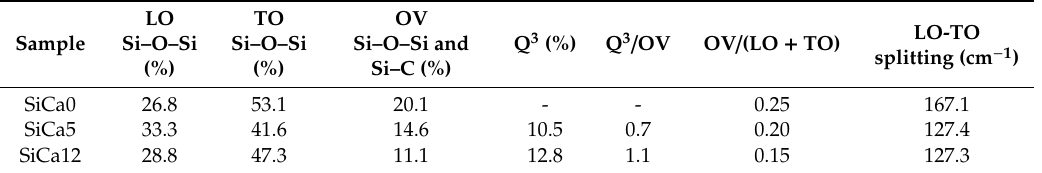
Table 2. Percentual fractions of band area and area ratios of fitted bands from the FTIR spectra shown in Figure 4 and the calculated LO-TO splitting for SiCa0, SiCa5, and SiCa12.